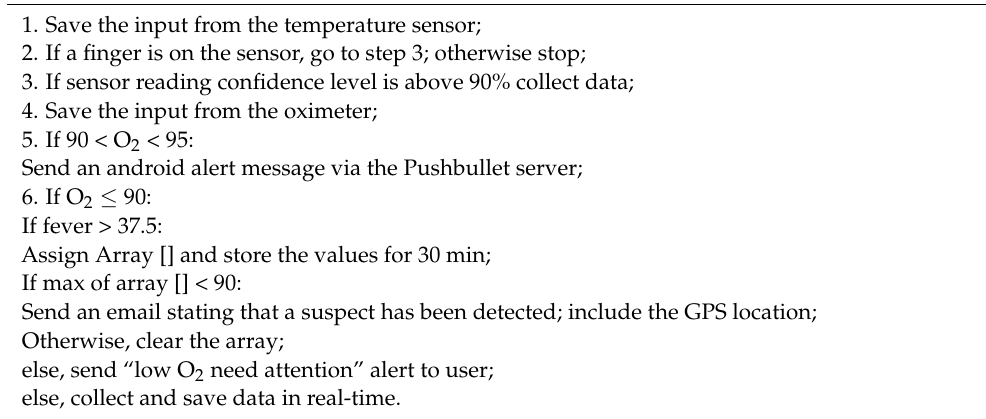
Algorithm 1. Pseudo-code: COVID suspect